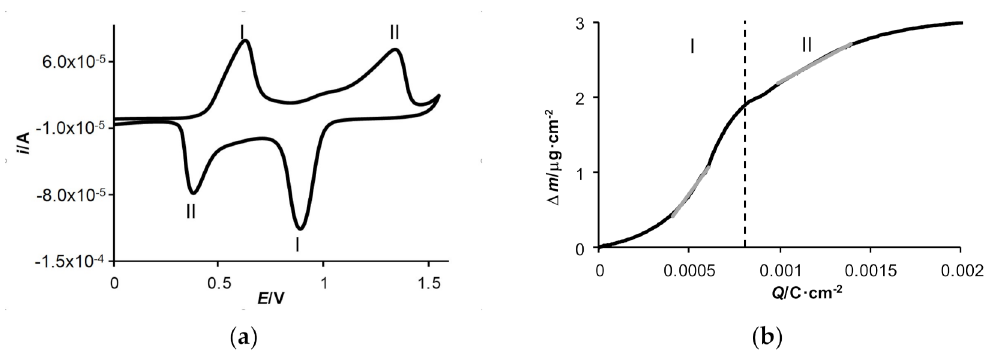
Figure 3. Poly [Ni(salcn(Me))] (1 electropolymerization cycle) in TBAClO 4 /CH 2 Cl 2 , Pt/quarzglas, v = 0.05 V · s − 1 , vs. Ag/AgCl; ( a ) cyclic voltammogram; ( b ) plot ∆ m vs. Q for anodic process; grey parts of the curve—trend lines for the ∆ m = f( Q ) relationship. I and II—peaks